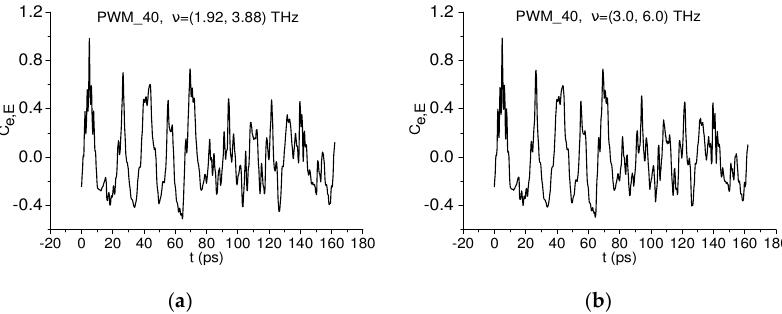
Figure 12. Correlation coefficient c e , E ( t n ) between the PWM_40 spectral line dynamics computed for the frequency pairs ν = (1.92, 3.88) THz ( a ), (3.0, 6.0) THz ( b ). Thus, in the spectrum of the PWM_40 main pulse, the presence of two pairs with doubled absorption frequencies ν = (1.92, 3.88) THz and (3.0, 6.0) THz is demonstrated. Both doubled absorption frequencies ν = 3.88, 6.0 THz lie in the high frequency range of the spectrum: ν > 3.0 THz.